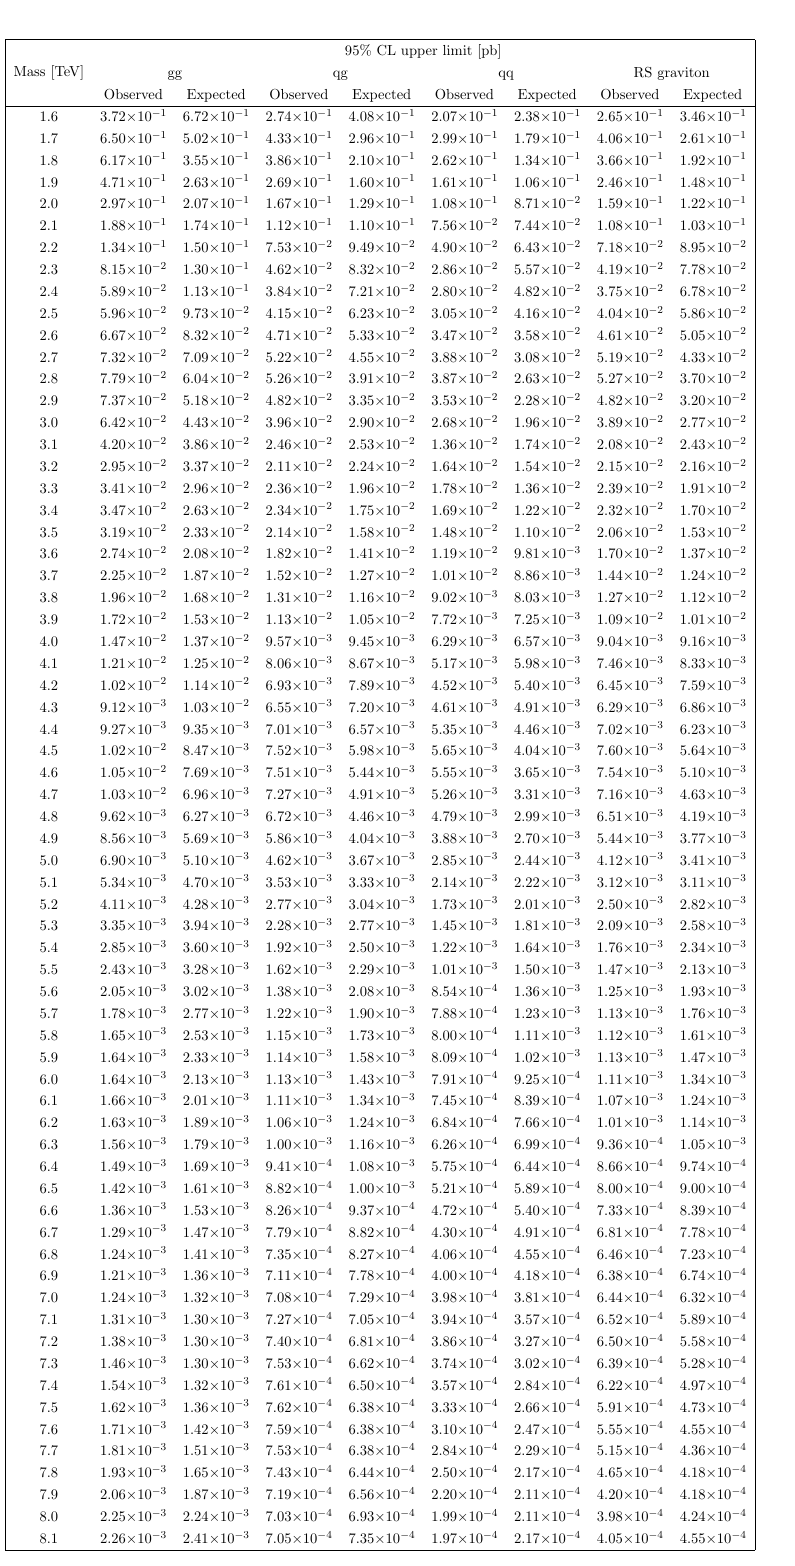
Table 2 . Limits from the high-mass search. The observed and expected upper limits at 95% CL on (cid:27)BA for gluon-gluon, quark-gluon, and quark-quark resonances, and an RS graviton are shown as functions of the resonance mass.